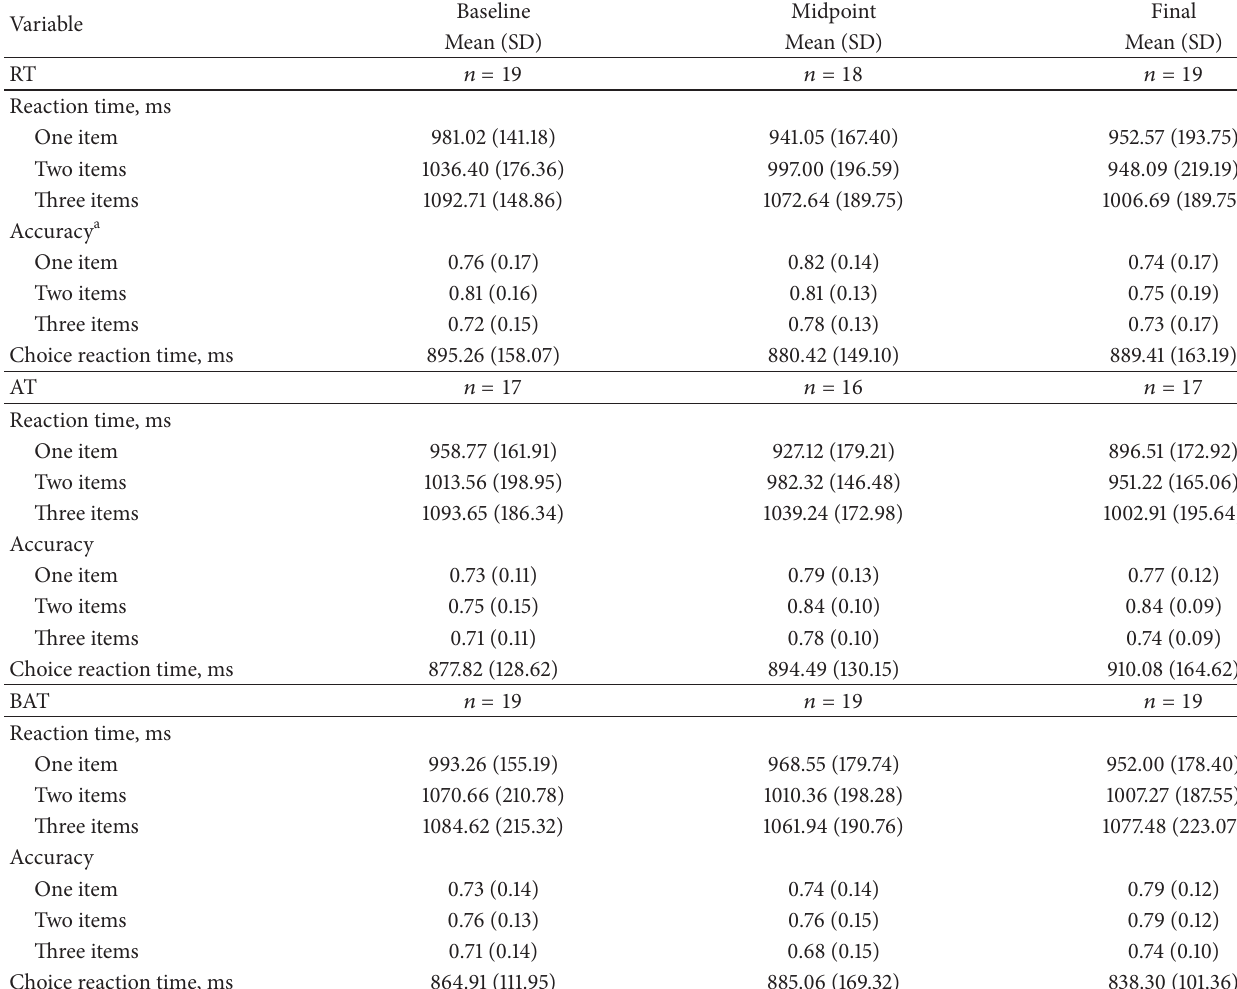
Table 3: Mean values (SDs) for spatial memory